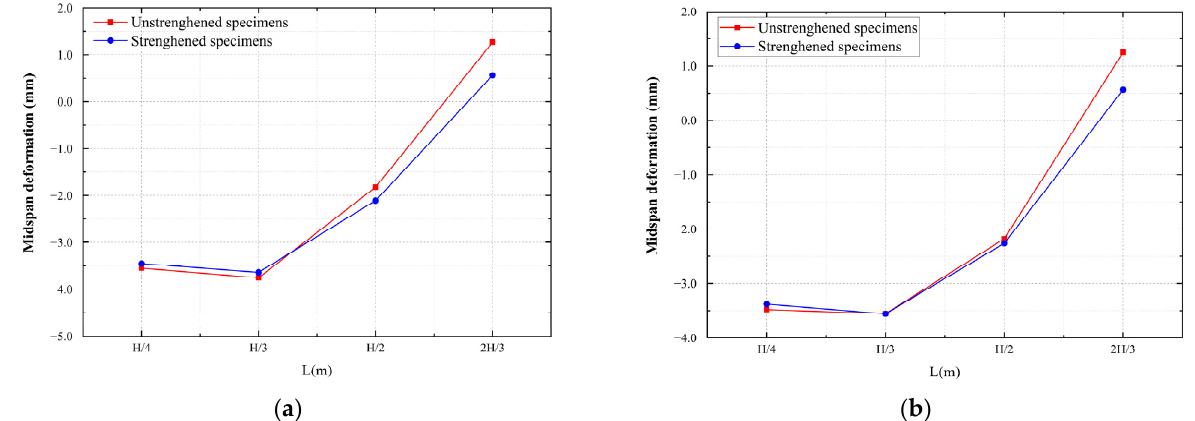
Figure 17. Midspan deformation: (a) CDP and (b) XFEM.